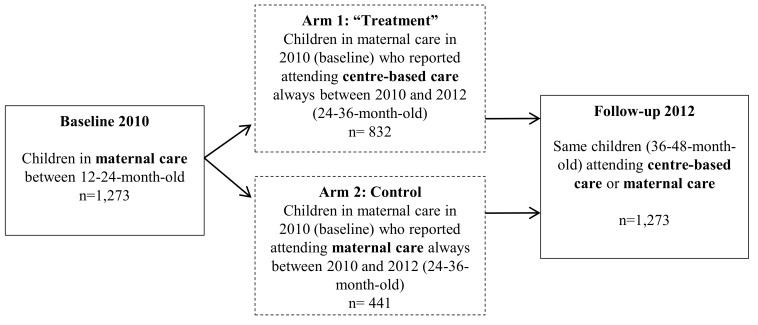
Definition of the study sample.